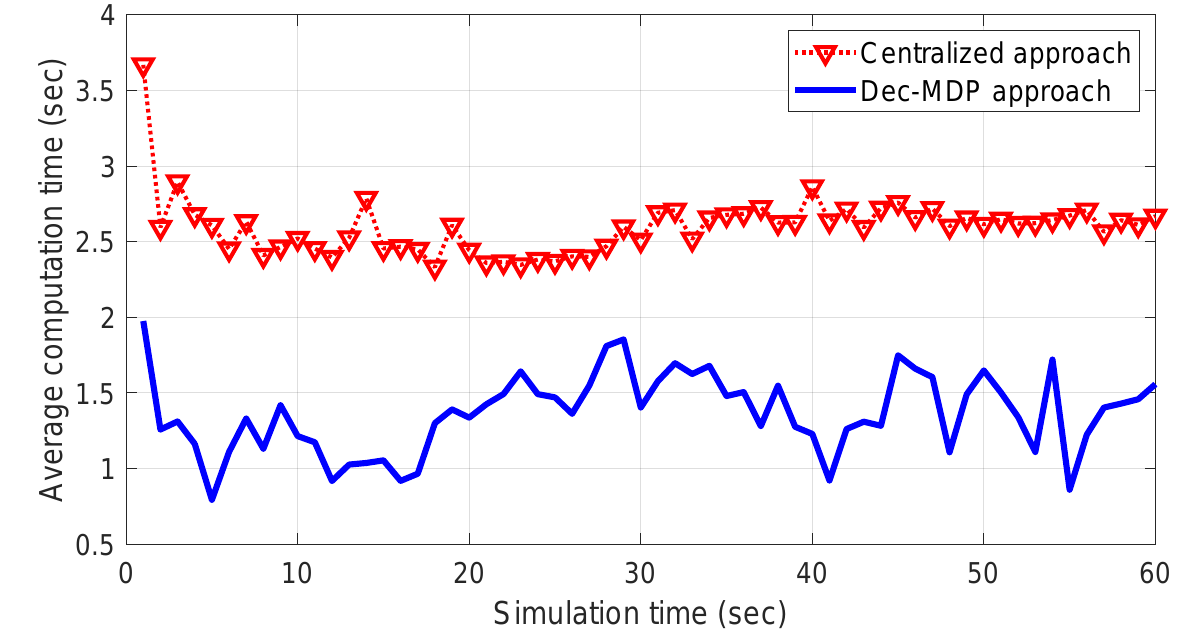
Figure 5. Computation time ( T c ): centralized vs. decentralized method.